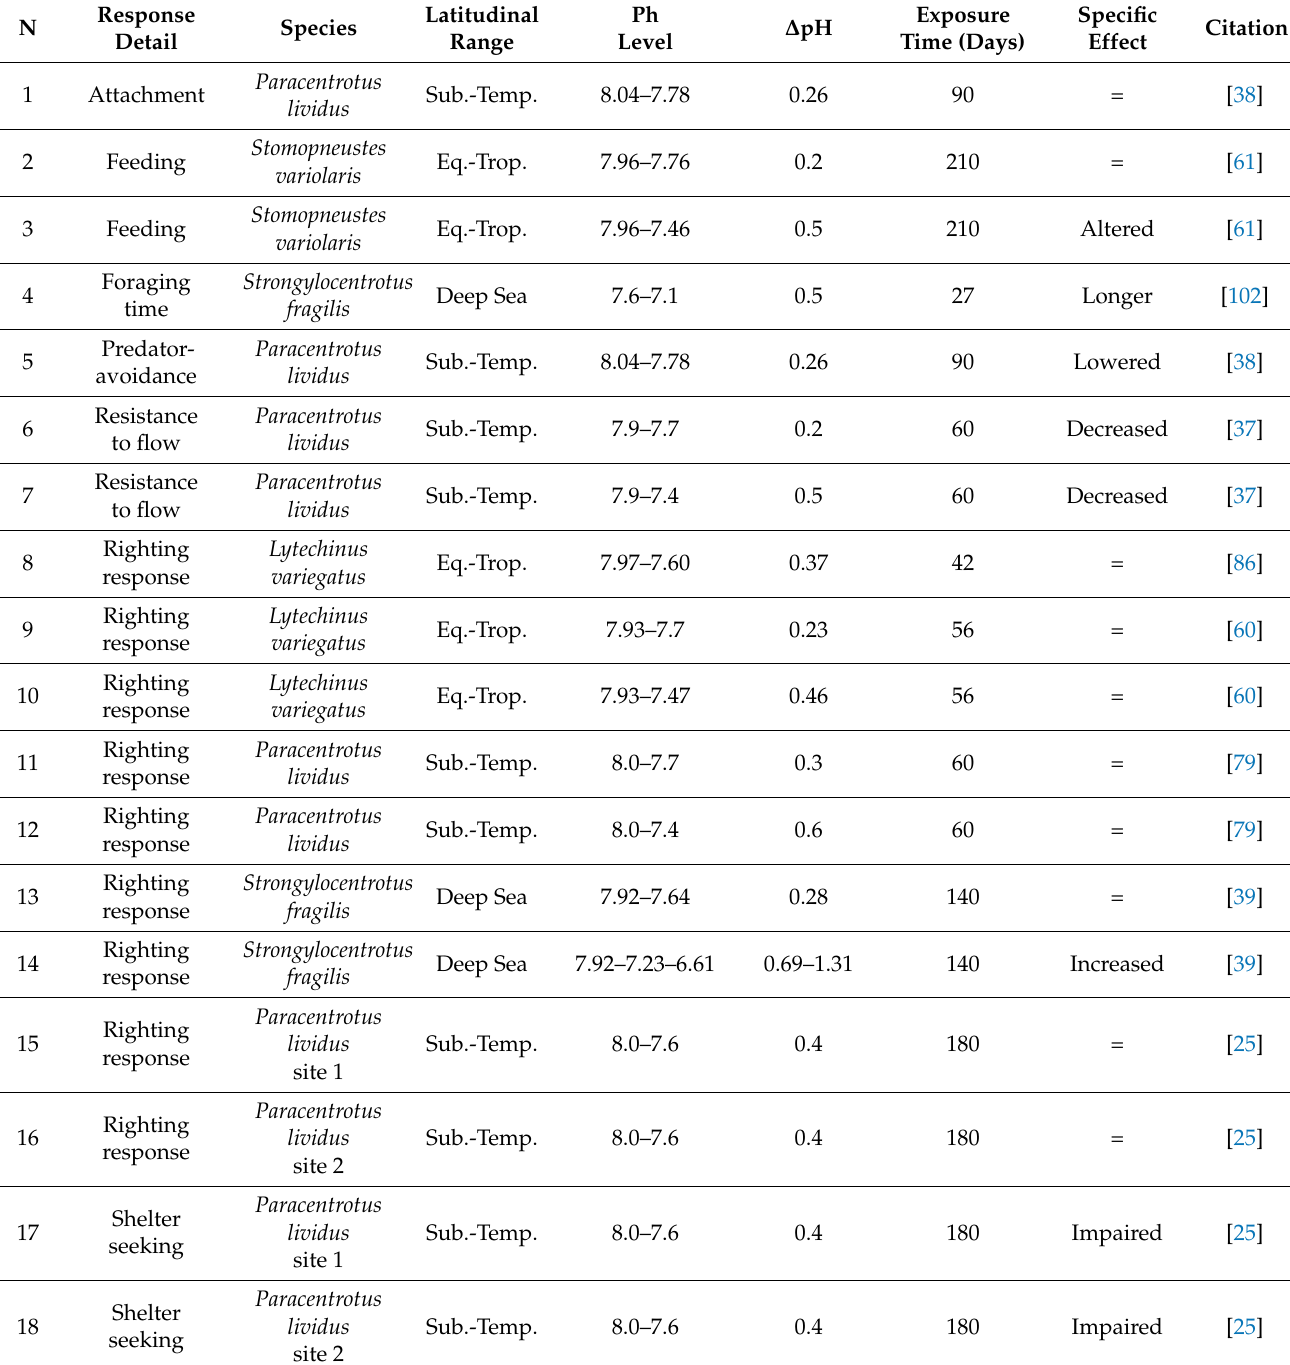
Table 3. List of studies performed on echinoid adult stage to investigate effects of SWA on behaviour. “pH level” contains the values of all the conditions tested; the first value is the control. In the case that the same article tested both a realistic ( ∆ pH ≤ 0.4; based on IPCC RCP8.5) and unrealistic scenario ( ∆ pH > 0.4), the two conditions were split. Abbreviations: Eq.-Trop. = Equatorial–Tropical; Sub.-Temp. = Subtropical–Temperate; Temp.-Pol. =